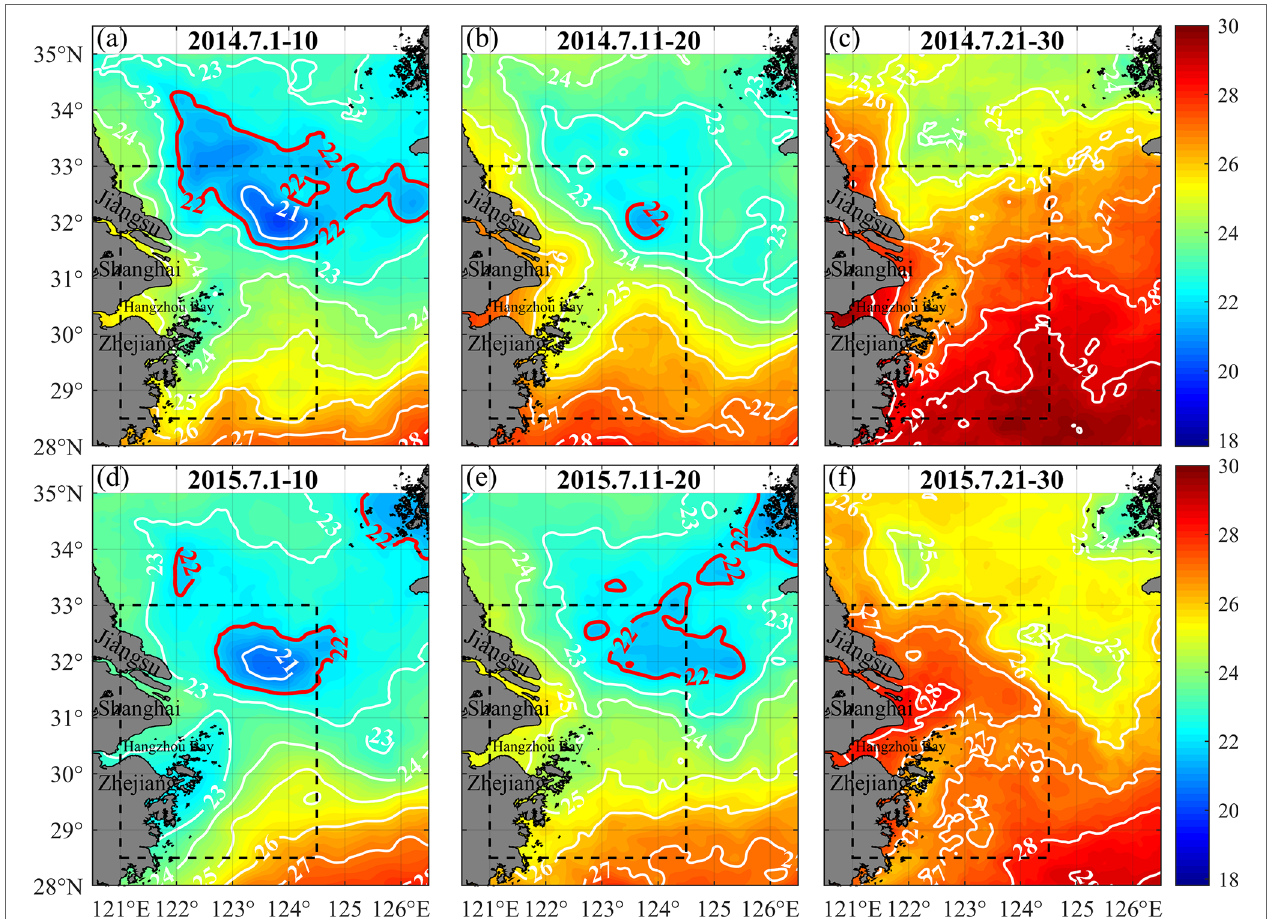
FIGURE 4 | Spatial distributions of the 10-day averaged satellite SST from July 1-10, July 11-20, and July 21-30 of 2014 (A-C) and 2015 (D-F) (red line represents the boundary of CWZs, black dashed box indicates the survey area shown in Figure 1B